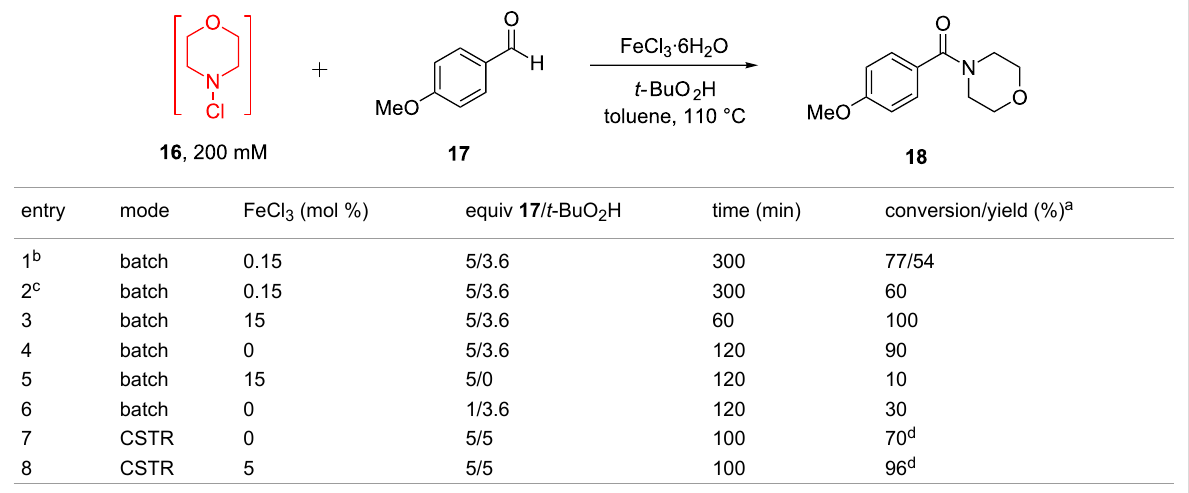
Table 3: Batch vs flow study of reaction of N -chloramine with an aldehyde.